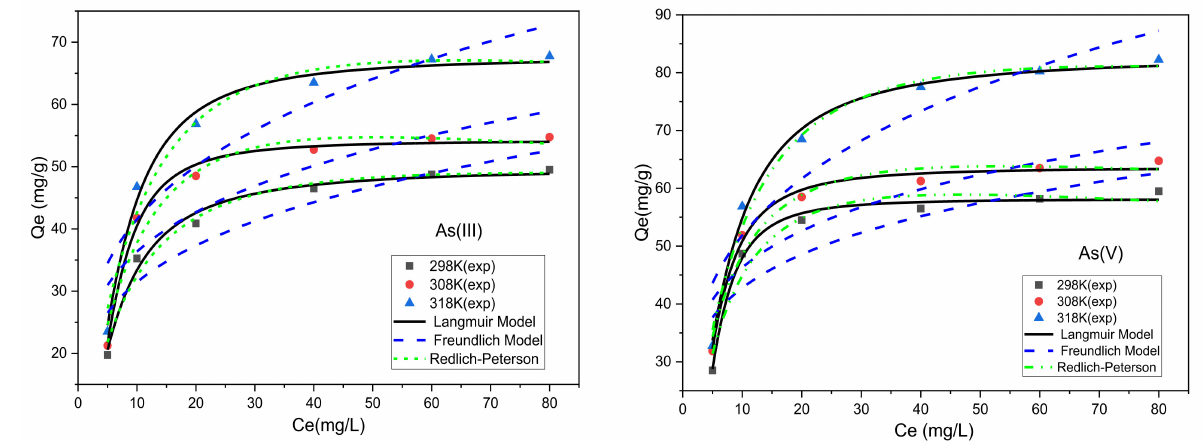
Figure 11. Fitting of Fe 3 O 4 @mZrO 2 -Re (Re = Y/La/Ce) for adsorption isotherm of As 3+ and As 5+ . Table 7. Adsorption Isothermal data of Fe 3 O 4 @mZrO 2 -Re (Re = Y/La/Ce) for As 3+ and As 5+ .